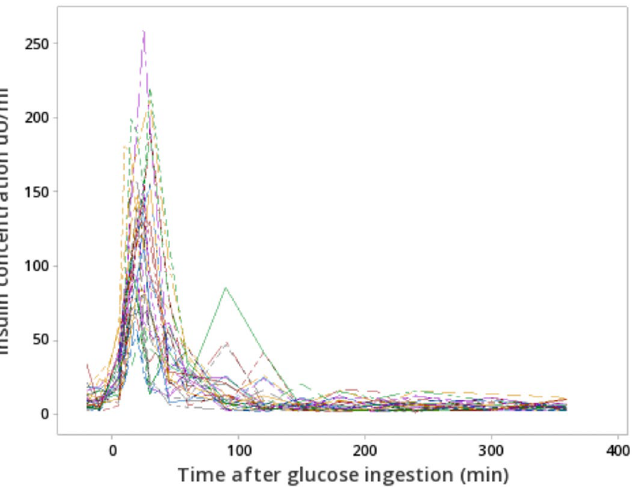
Figure 1. Plasmatic insulin concentration of 95 kg pigs after ingestion of a same dose of oral glucose (1.75 g/kg of BW).